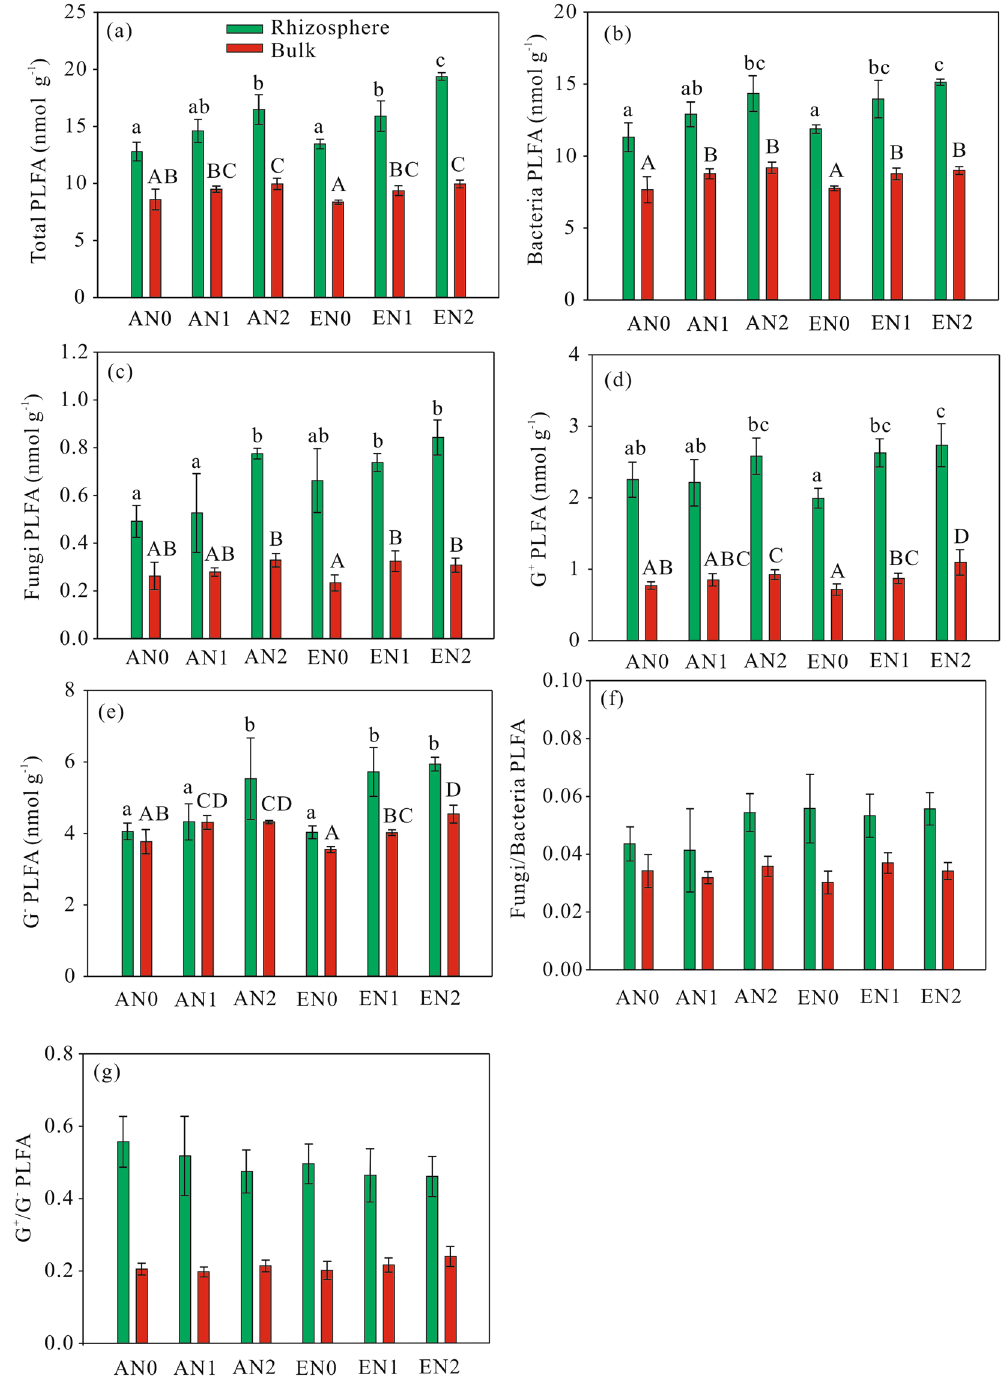
Figure 3. Total PLFA ( a ), bacterial PLFA ( b ), fungal PLFA ( c ), G + PLFA ( d ), G − PLFA ( e ), fungal/bacterial PLFA ( f ), and G + /G − PLFA ( g ) in the rhizosphere and bulk soil in the treatments. Different lowercase letters indicate significant differences between treatments in the rhizosphere, and different uppercase letters indicate significant differences between treatments in the bulk soil. AN0, ambient CO 2 and no N added; AN1 ambient CO 2 and N supply at a rate of 2.5 g N m − 2 y − 1 ; AN2, ambient CO 2 and N supply at a rate of 5 g N m − 2 y − 1 ; EN0, elevated CO 2 and no N added; EN1, elevated CO 2 and N supply at a rate of 2.5 g N m − 2 y − 1 ; EN2, elevated CO 2 and N supply at a rate of 5 g N m − 2 y − 1